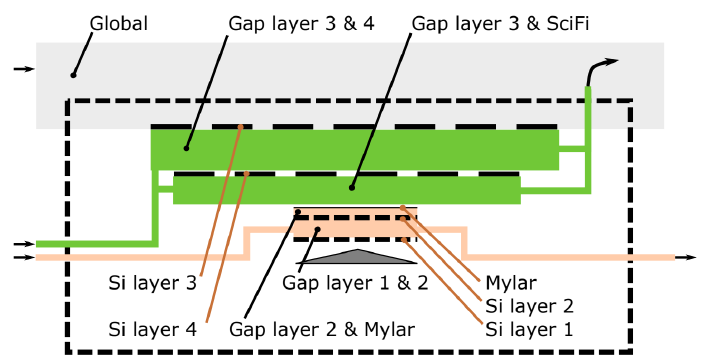
Figure 7. Sketch of the helium cooling system for the pixel tracker central station (the area inside the dashed box) showing the inner layer flow (pink), the outer layer flow (green) and an additional global flow inside the magnet (gray)